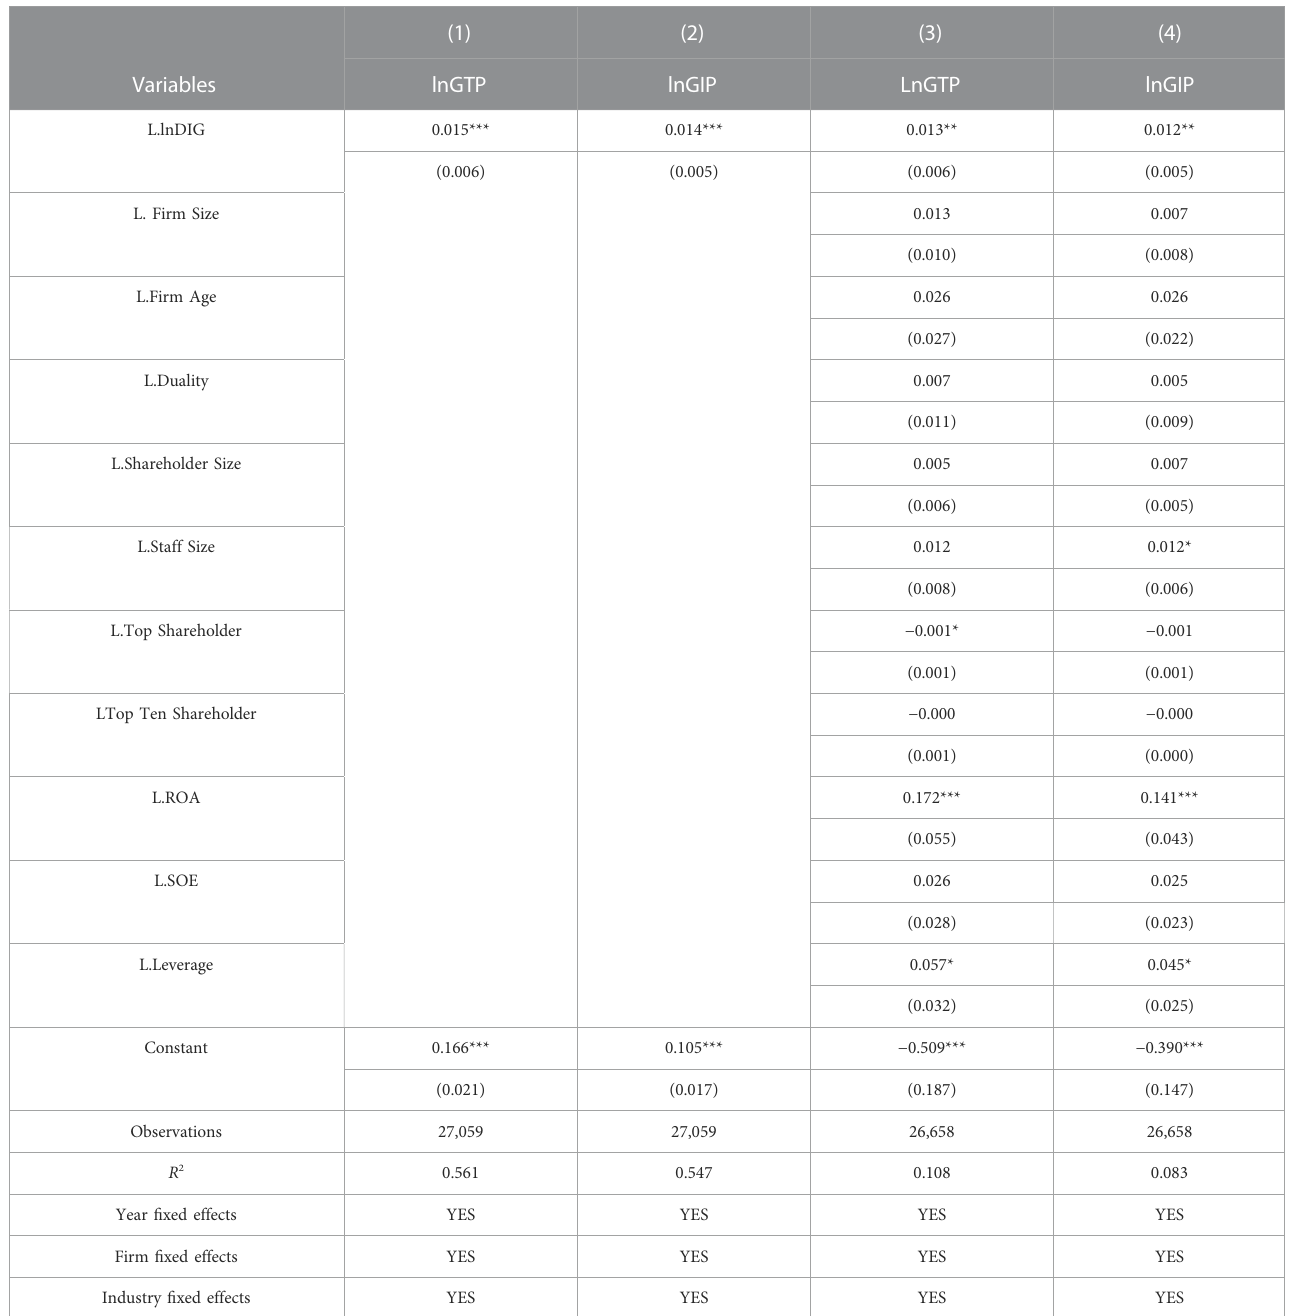
TABLE 5 Baseline